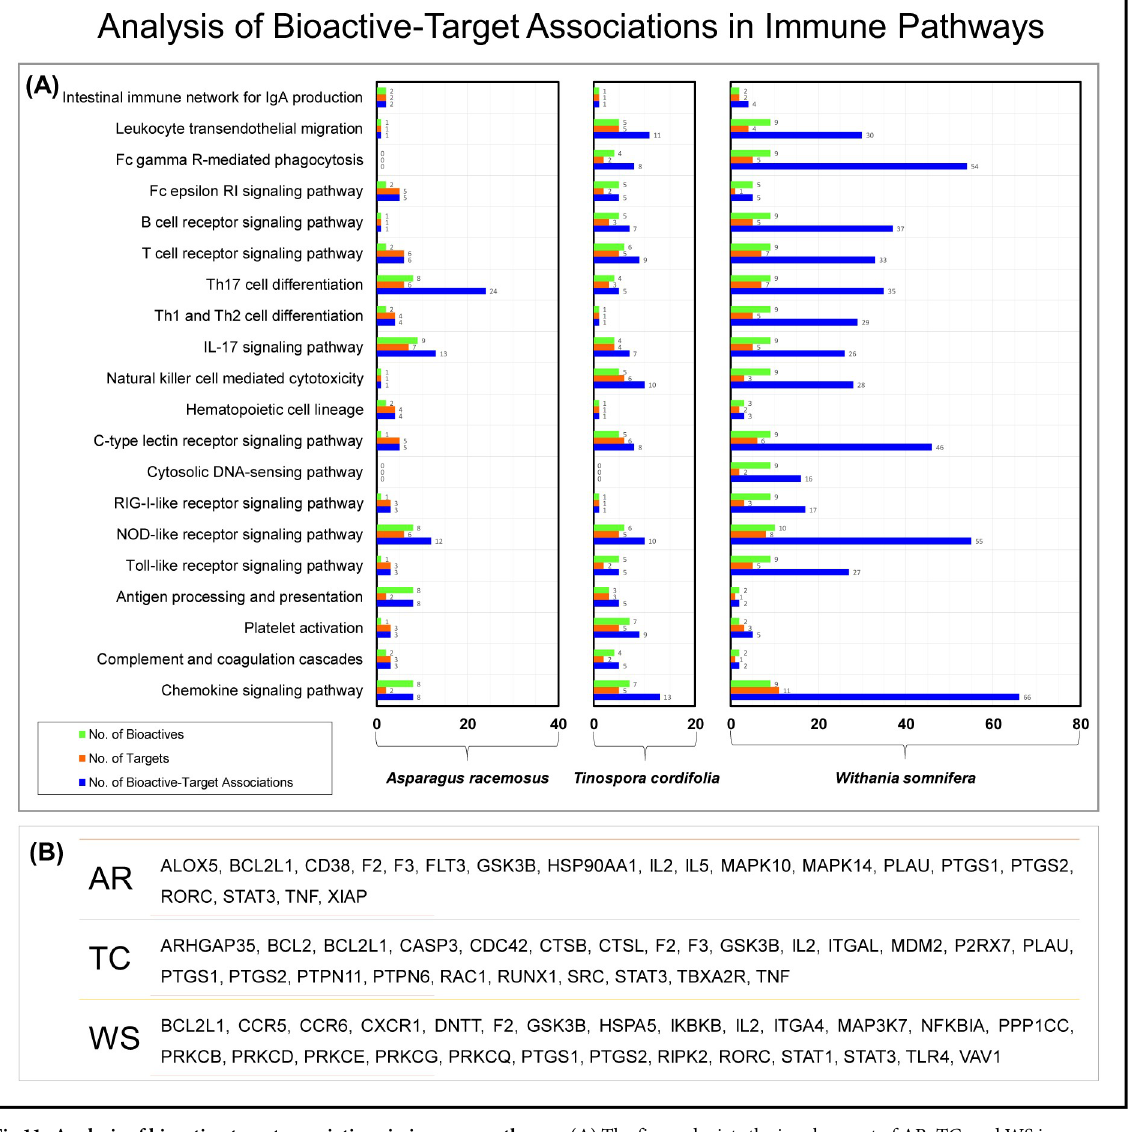
a particular pathway. (B) The table lists all immune targets of AR, TC, and